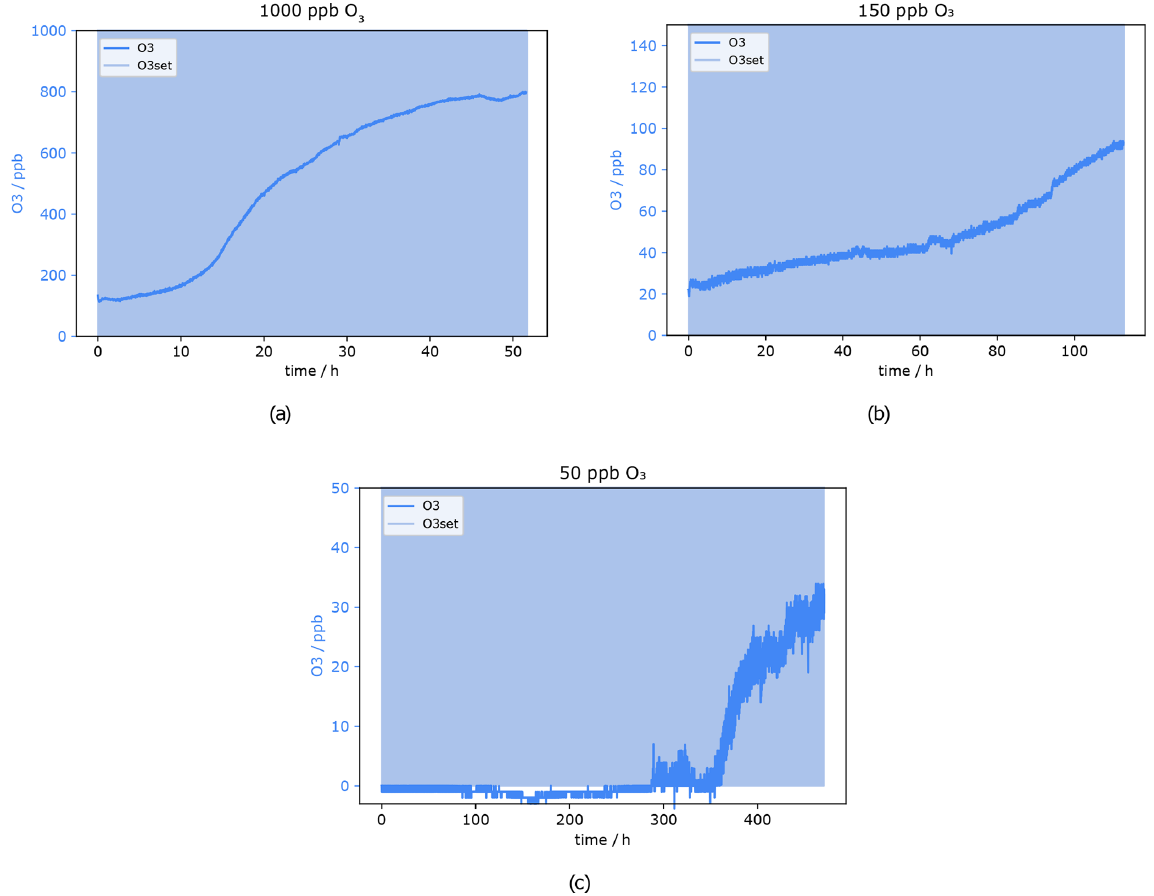
Figure 11. O 3 mixing ratio after Na 2 S 2 O 3 scrubber at 0% RH. Flows and O 3 levels before scrubber: (a) 220sccm, 1000ppb; (b) 255sccm, 150ppb; and (c) 230sccm,